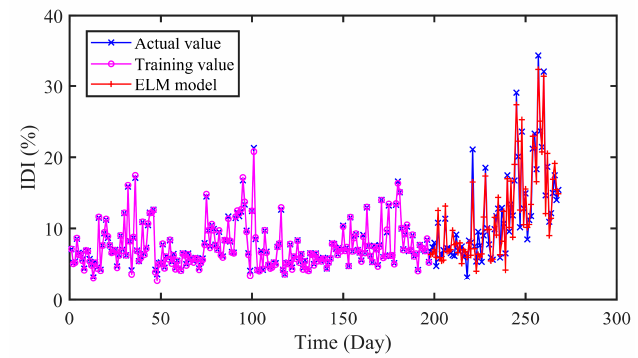
Figure 10. The predicted results of SVR model.